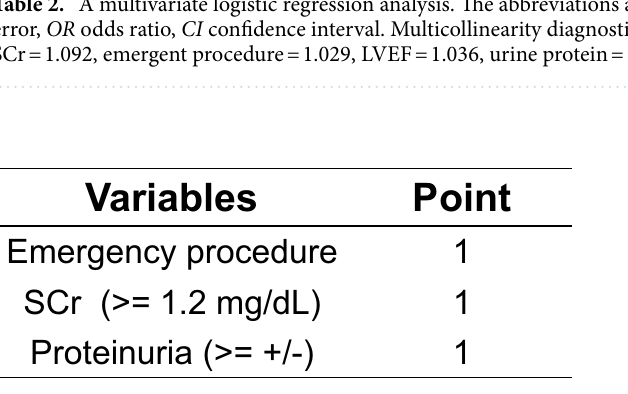
Figure 1. Predictive score for contrast-associated acute kidney injury (CA-AKI). The regression coefficients estimated from the logistic model were used to develop the score. The cutoff value of the SCr was calculated according to the Youden index. Akaike information criterion = 228.26. SCr: serum creatinine.